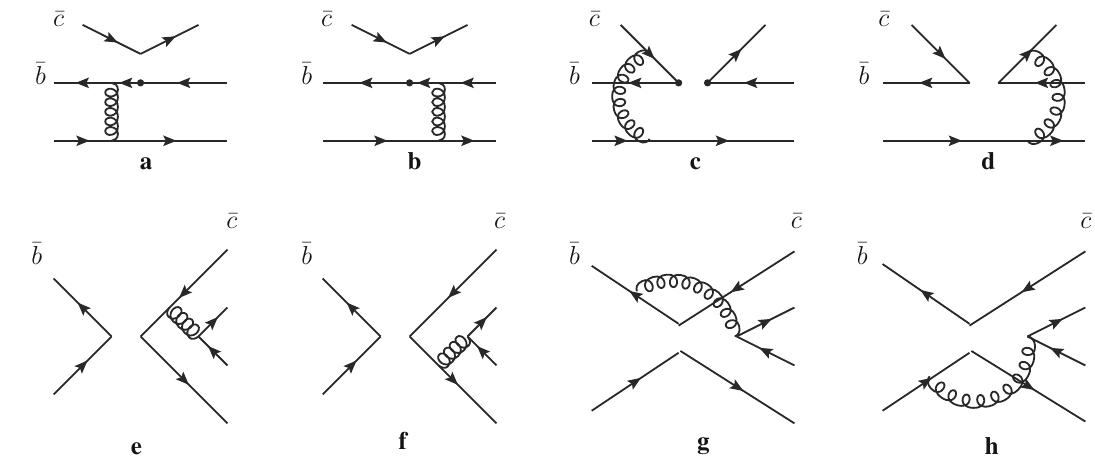
( ∗ ) S decays in PQCD